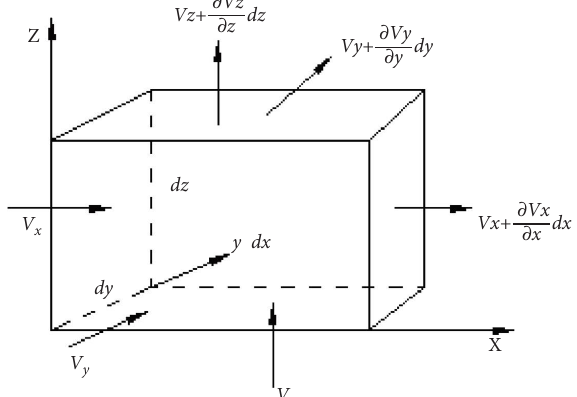
Figure 1: Percolation diferential